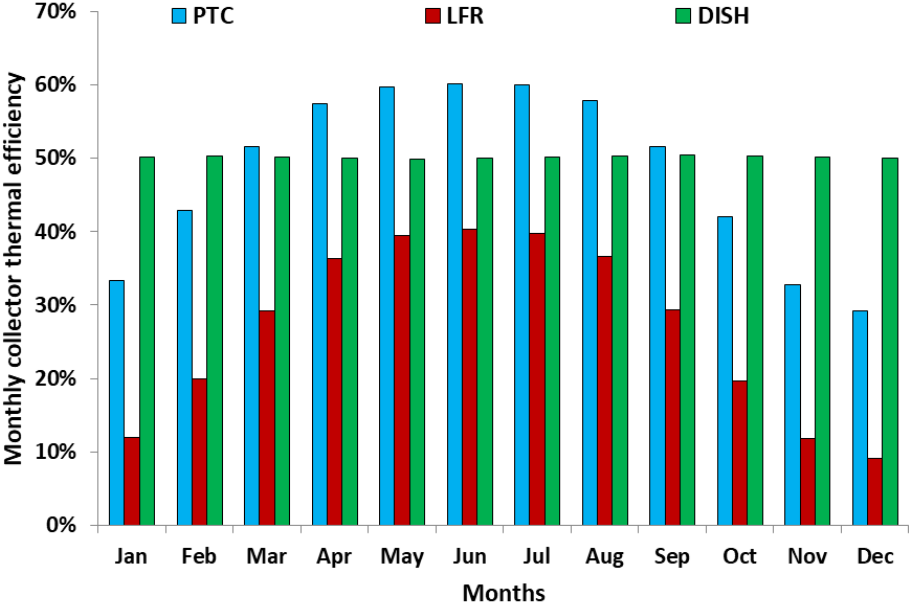
Figure 8. Monthly collector thermal e ffi ciency for the three solar collectors.